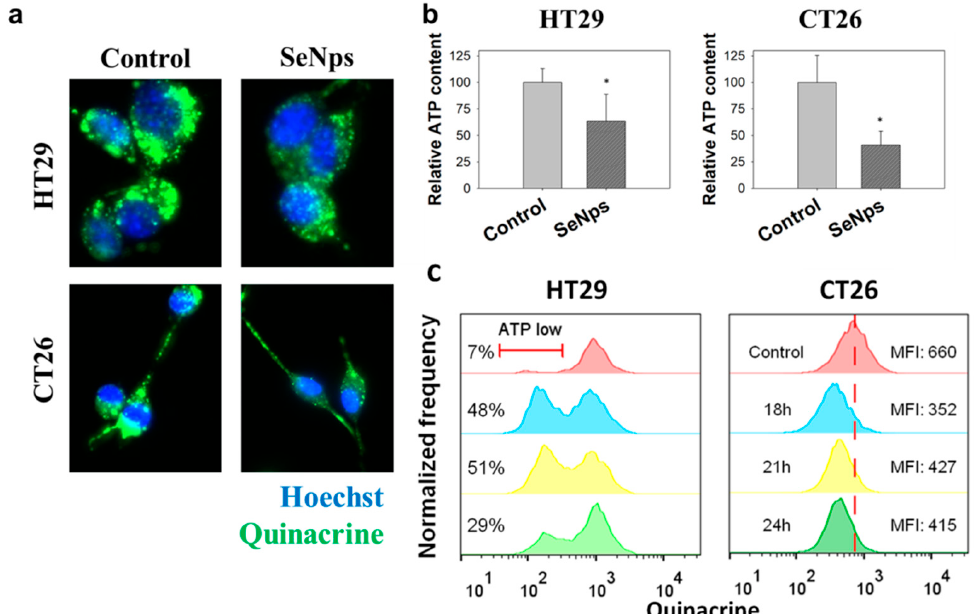
Figure 6. ATP secretion from SeNps-treated HT29 or CT26 cells. ( a ) Fluorescence microscopy images of ATP-containing vesicles in live HT29 or CT26 cells. Cells were grown in coverslips, treated with 15 µ g/mL SeNps for 21 h and labelled with the ATP-marker quinacrine (green). A lower cellular MFI was observed in both SeNps-treated HT29 or CT26 cells when compared to the controls, untreated cells (magnification: 1200 × ). ( b ) Quantification of the relative cellular quinacrine fluorescence intensity, expressed as relative ATP content. A statistically significant drop in both HT29 and CT26 cells pre-treated with SeNps (* p < 0.05, Student’s t -test) was observed. ( c ) The observed lower ATP levels in SeNps-treated cells were confirmed by flow cytometry analysis. Quinacrine-labelled HT29 or CT26 cells pre-treated with 15 µ g/mL SeNps for 18, 21 or 24 h were analysed in an Attune NxT flow cytometer. Fluorescence intensity histograms of cells. MFI stands for median fluorescence intensity. Data were analysed with FlowJo v.10. Results presented are representative of at least three independent experiments, ( p < 0.05, Student’s t -test).